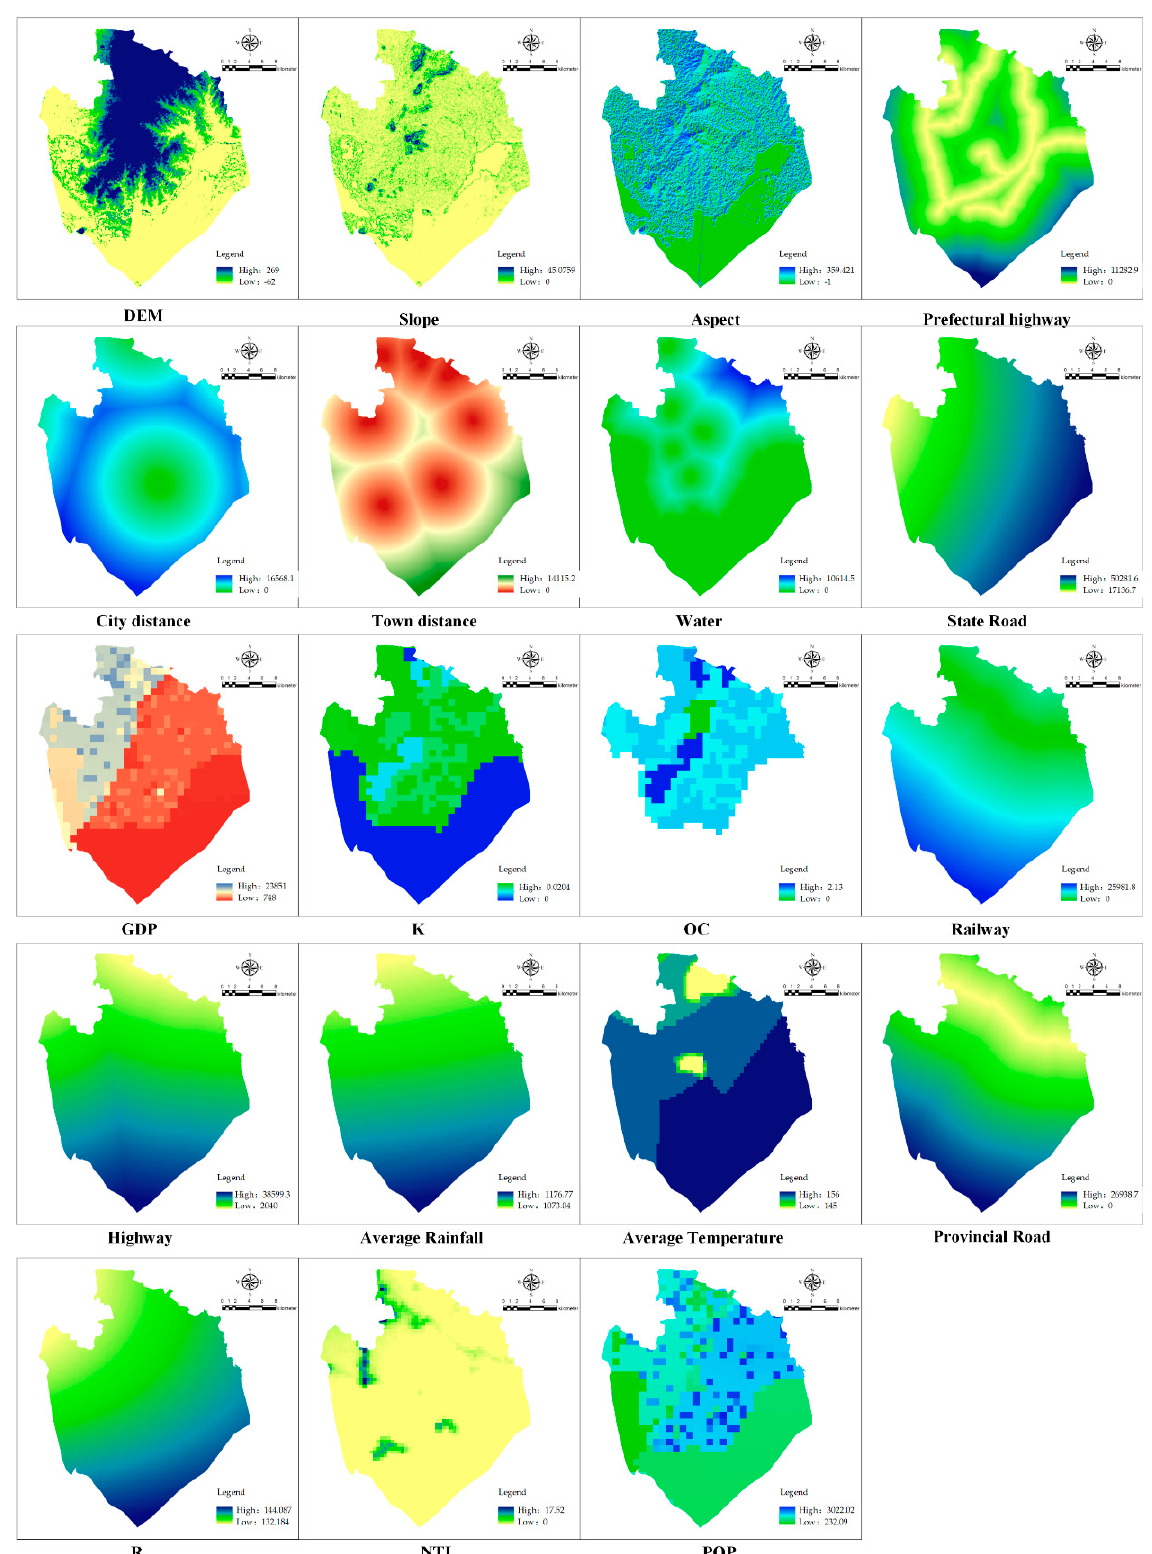
Figure 3. Driving factors for the evolution of rural settlements.